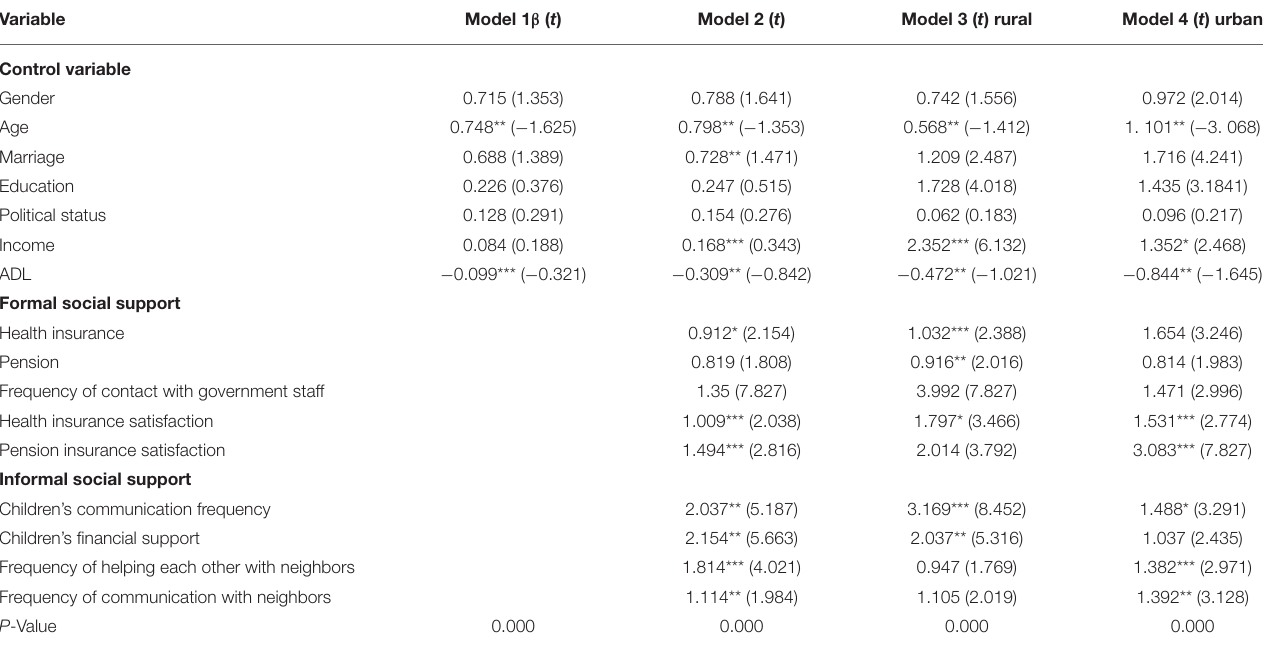
TABLE 4 | The impact of formal and informal social support on utilization of outpatient healthcare service.